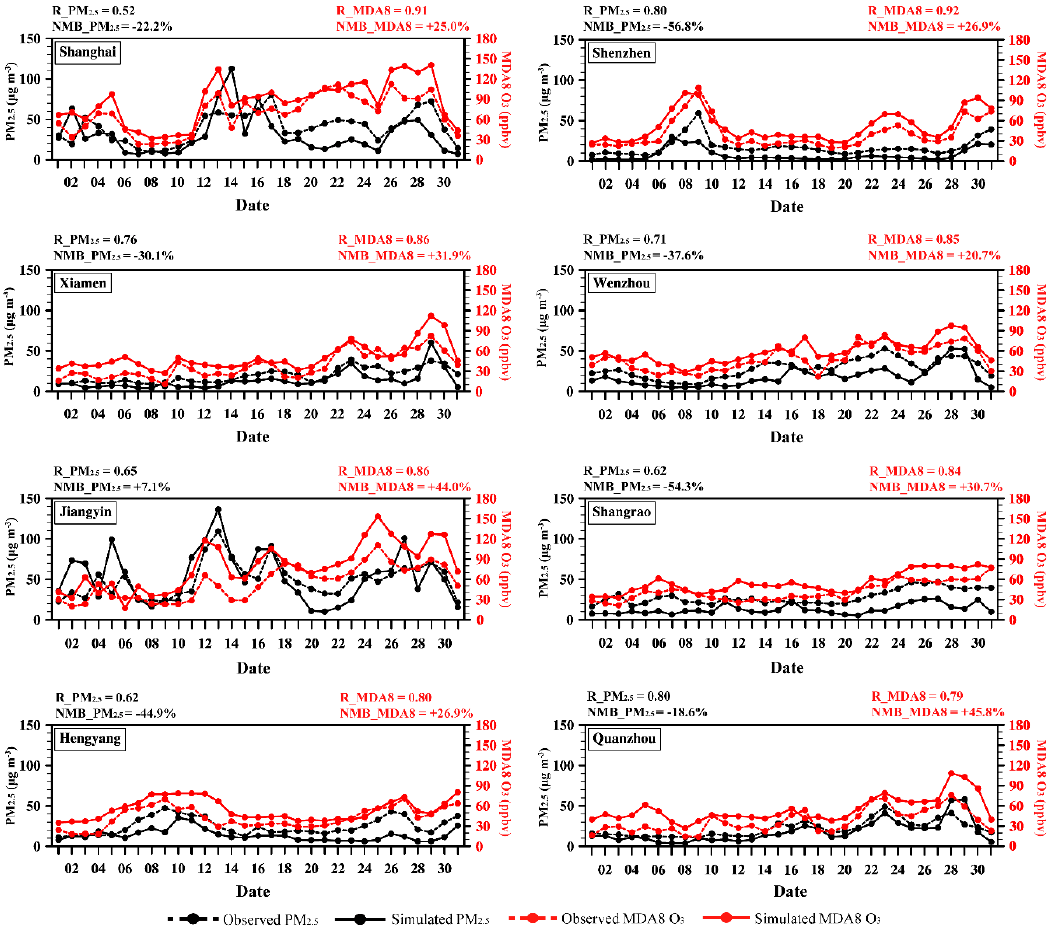
Figure 4. Observed and simulated daily PM 2.5 and MDA8 O 3 concentrations for southern cities in July. Observed (simulated) concentrations are shown in dashed (solid) lines. The PM 2.5 (MDA8 O 3 ) concentrations are shown in black (red) lines. The correlation coefficient ( r ) and normalized mean bias (NMB) between the observations and simulations are shown above each panel.